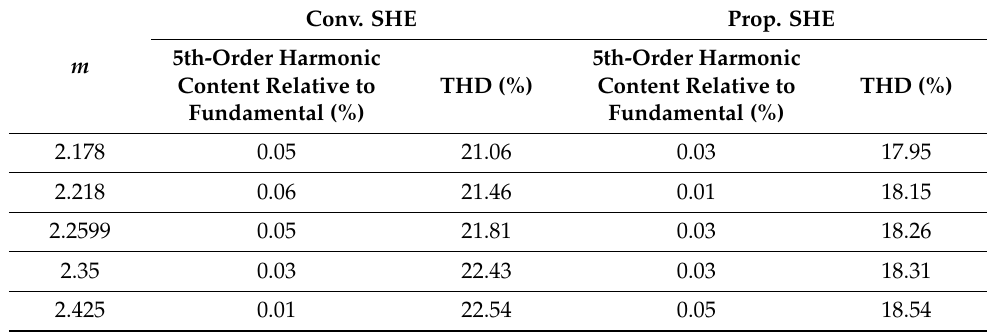
Table 2. Simulation results for 5th order harmonic elimination.